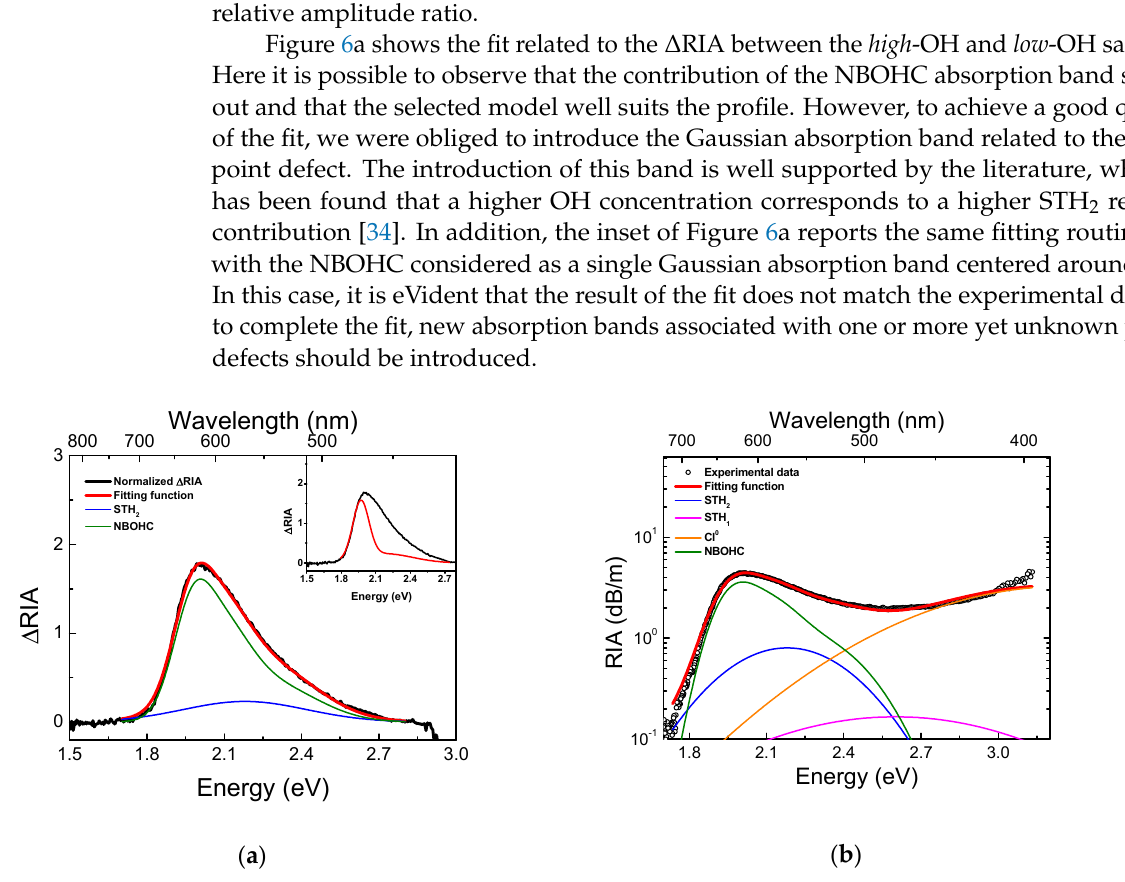
Figure 6. ( a ) Fitting function of the difference between the normalized RIA ( Δ RIA) of the high - and the low -OH samples, taking in account the model of the NBOHC of [39]. The inset shows the attempt to fit the Δ RIA with the NBOHC considered as a single Gaussian band. ( b ) Fitting function of the RIA at 300 kGy of the high -OH sample.